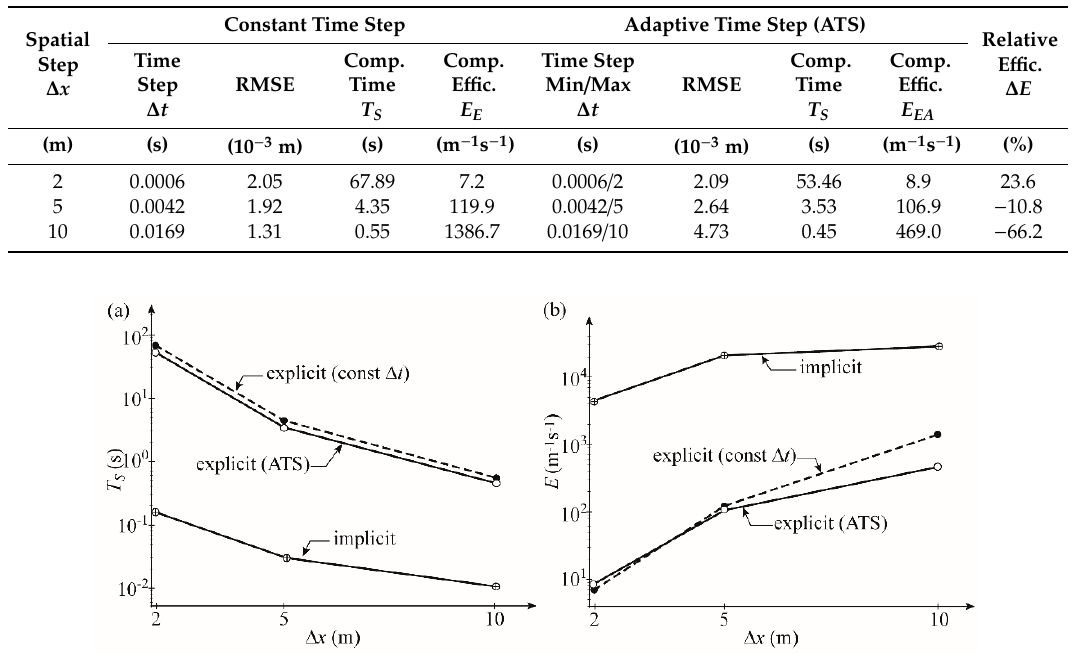
Figure 6. Comparison of the explicit, explicit with ATS, and implicit schemes ( θ = 0.5 and ω = 0.7) with regard to computation time T S ( a ) and computational e ffi ciency E ( b